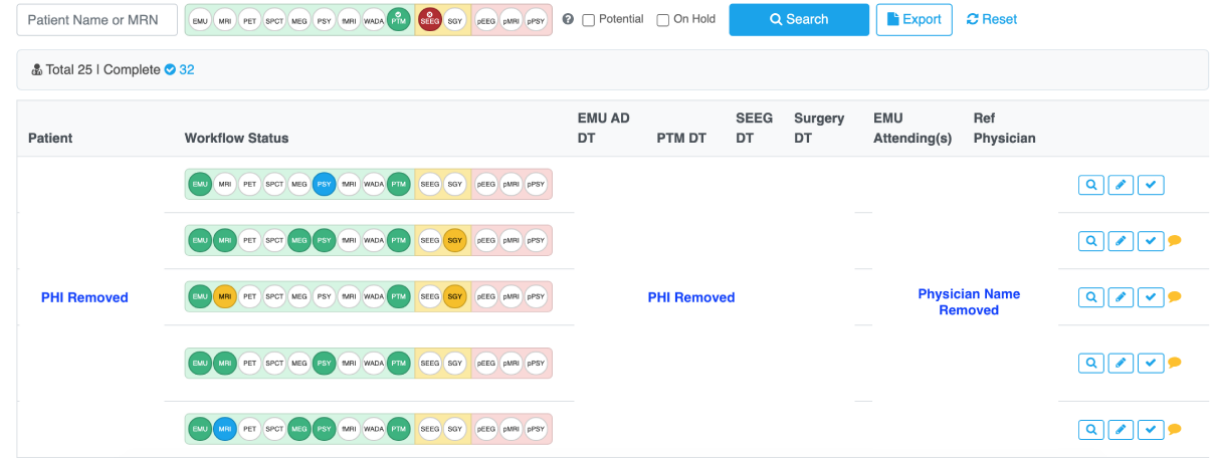
Figure 4. Tracker of epilepsy surgery candidates. AD: admission; DT: date; EMU: Epilepsy Monitoring Unit; MRN: medical record number; PHI: protected health information; PTM: patient management; Ref: referring; SEEG: